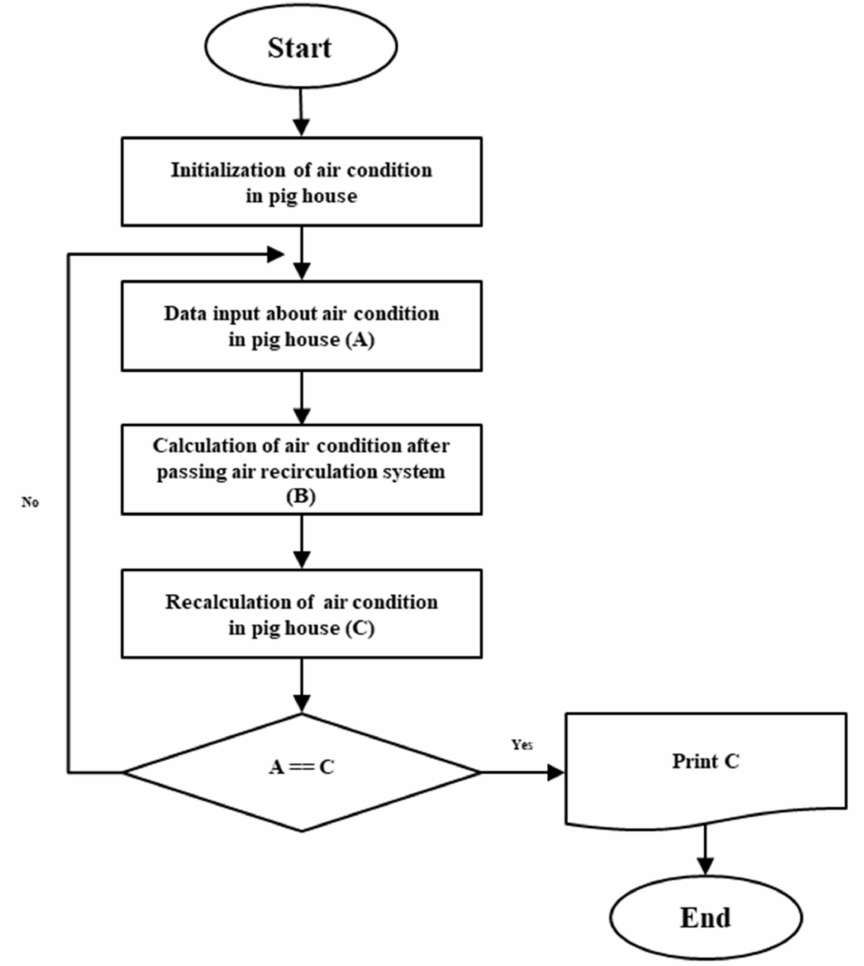
Figure 6. Algorithm of the numerical design of the ARVS. At the stage (A), the boundary conditions of air can be set. After passing the air recirculation system, the air condition can be changed at stage (B). Finally, the output data (C) can be compared with the results of